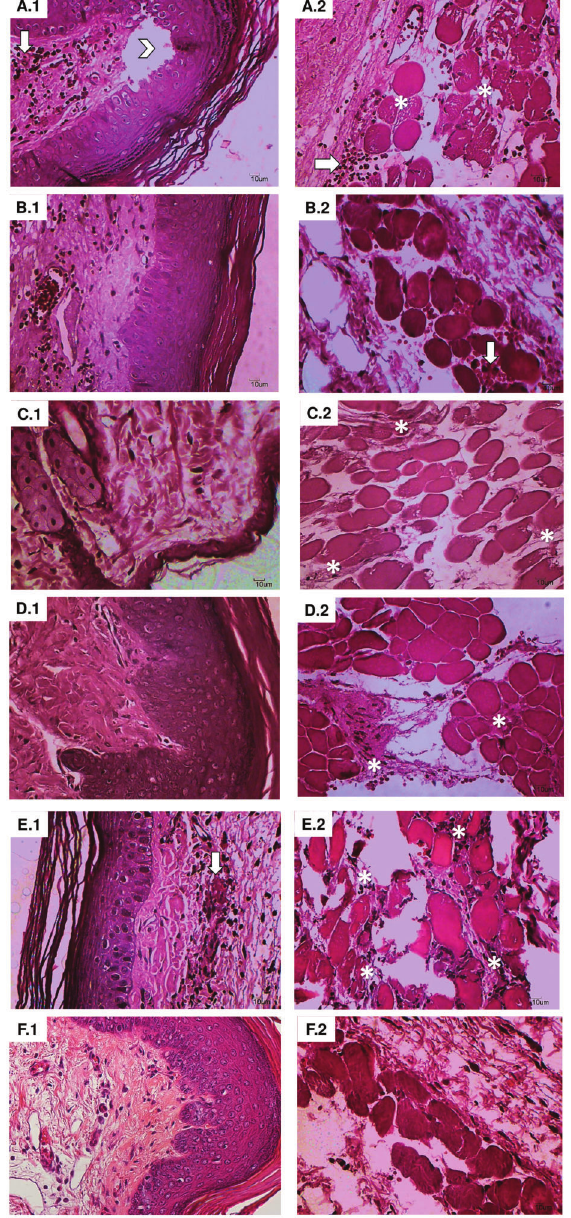
Figure 4. Histological analysis of edema induced by Brede- meyera jararacussu venom and neutralization by Bothrops fl oribunda extract. Epidermis/dermis ( 1 ) and Hypoderm/muscle tissue ( 2 ). A.1/A.2 : Sub-plantar injection of BjuV 50 m g/50 uL; B.1/ B.2 : Pre-treatment ip with BFRE 150 mg/kg; C.1/C.2 : Post- treatment ip with BFRE 150 mg/kg; D.1/D.2 : Pre-incubated BFRE: BjuV, 1:3 w/w; E1/E.2 : antivenom serum, suf fi cient quantity to neutralize 500 g of the venom; F.1/F.2 : saline control. A : Edema (arrow head). A to E : Edema, in fl ammatory cells, and destruction of muscle fi bers at different levels (asterisks). A , B , and E : mild hemorrhagic areas (arrows). F : no alterations. Light microscope at (cid:2) 400, HE staining. Scale bar: 10 m m.